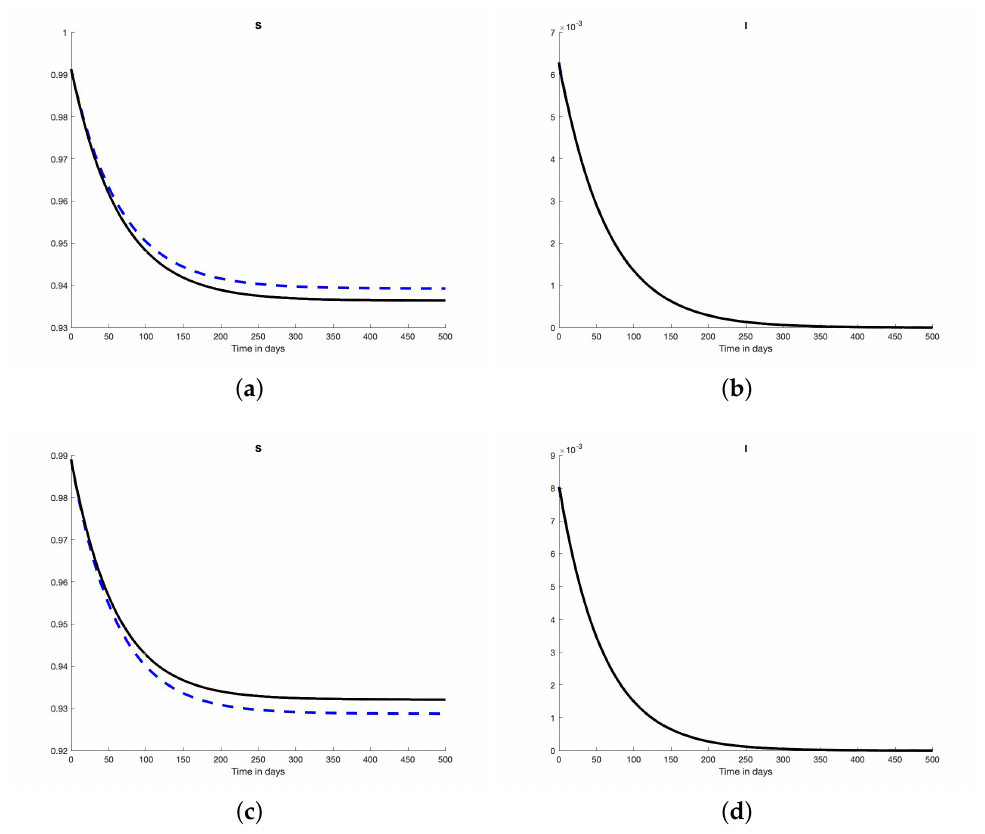
Figure 4. Scenario 2: States. ( a ) 0.95 γ model : S and S ∗ (- -); ( b ) 0.95 γ model : I and I ∗ (- -); ( c ) 1.05 γ model : S and S ∗ (- -); ( d ) 1.05 γ model : I and I ∗ (- -). It is obvious then that the tracking of I ∗ yields to deviate from R ∗ and β ∗